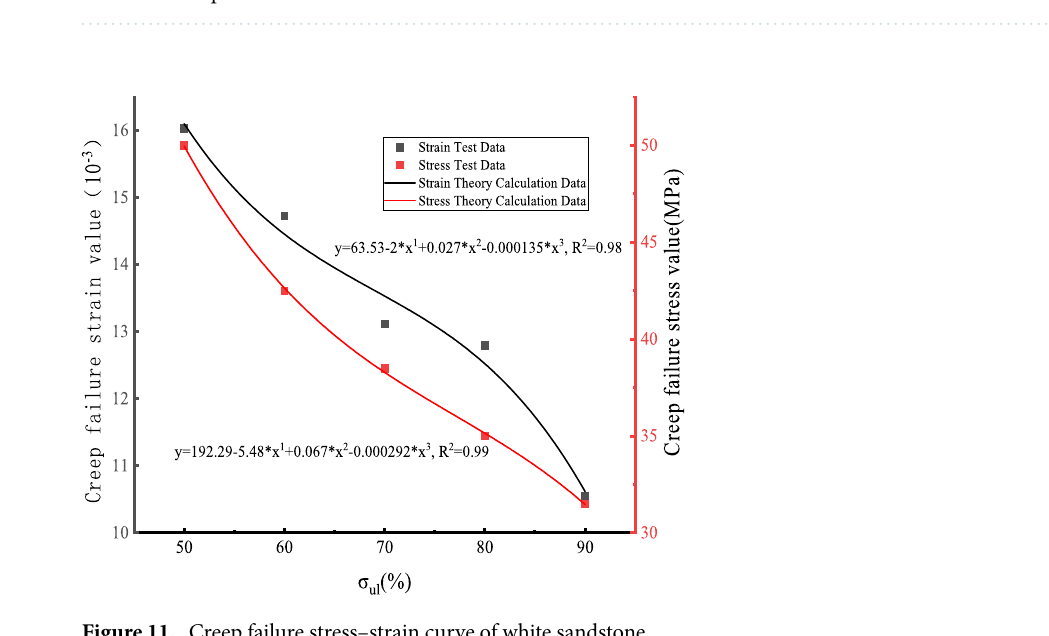
Table 2. Creep strain of sandstone under different stress levels.